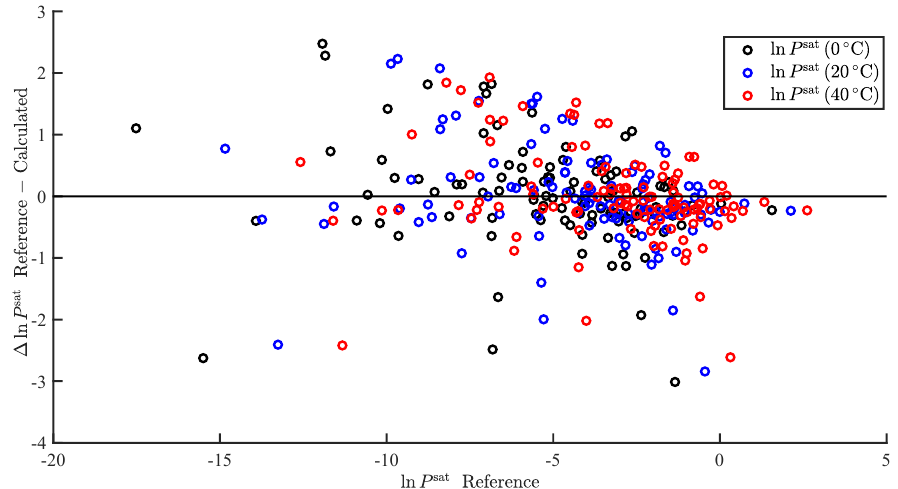
Figure 2. Residual plot of the difference between the reference and calculated (using Equation (17)) values of ln P sat at 0, 20, and 40 ◦ C, as indicated, versus the reference values. P sat is in units of bar. The solid line corresponds to the y = 0 line and is drawn as a reference.